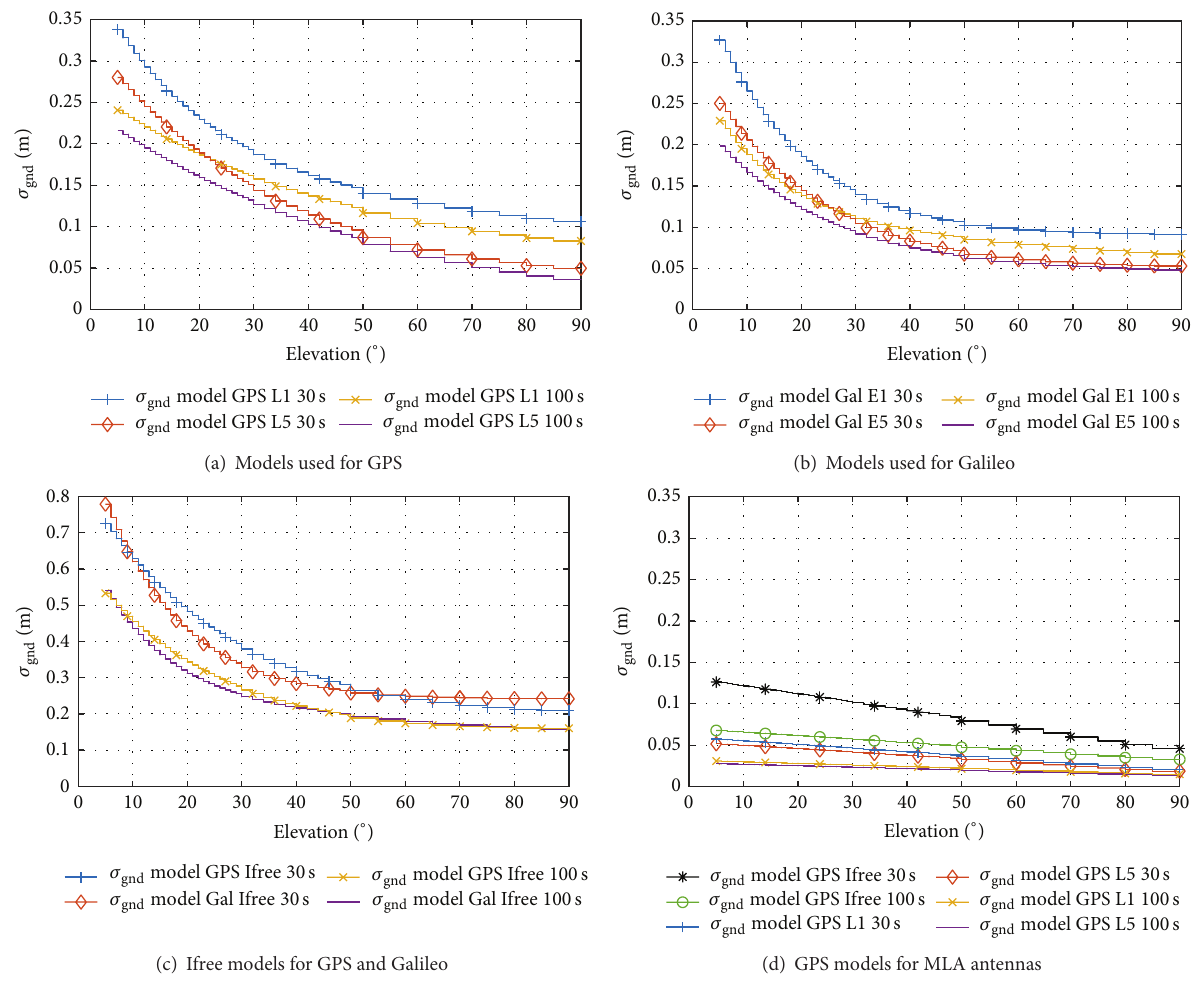
Figure 5: 𝜎 curves for different processing gnd